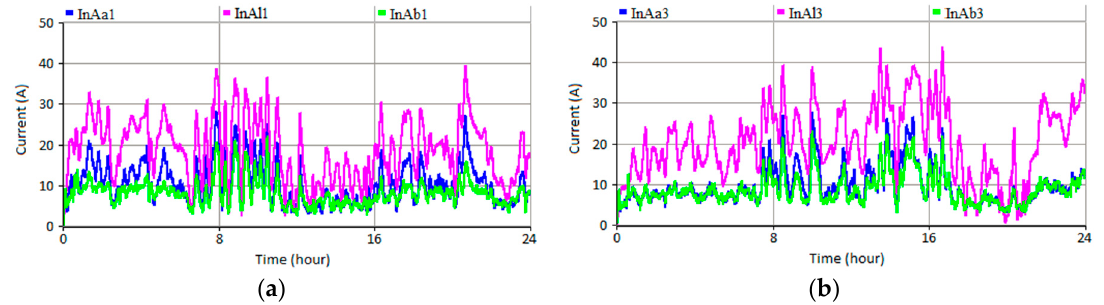
Figure 13. MG dynamic compensation performance: ( a ) MG1; ( b ) MG3.